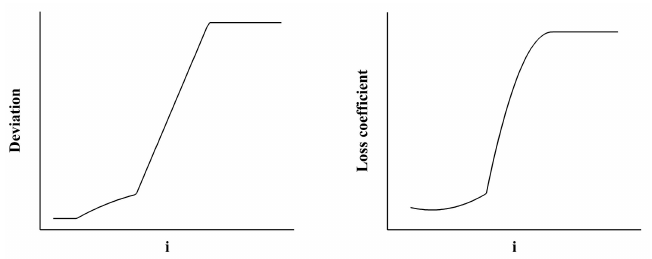
Figure 2. Correlation between deviation angle and loss coefficient with attack